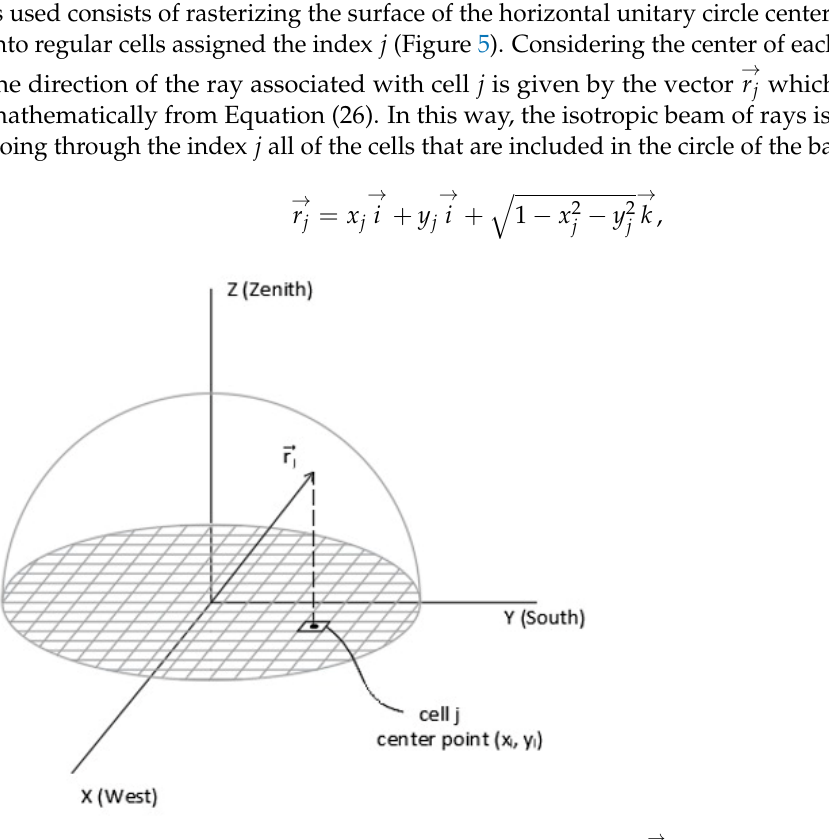
Figure 5. Geometric construction to obtain the set of isotropic rays 𝑟 (cid:3115) (cid:4652)(cid:4652)⃗ .